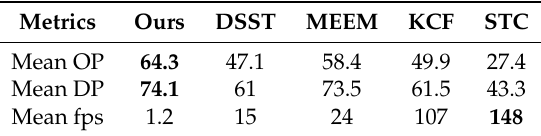
Table 2. Comparison with state-of-the-art trackers on the occlusion sequences. The results are presented in terms of mean OP (%) at an overlap threshold of 0.5, DP (%) at a threshold of 20 pixels, and fps. The optimal results are highlighted in